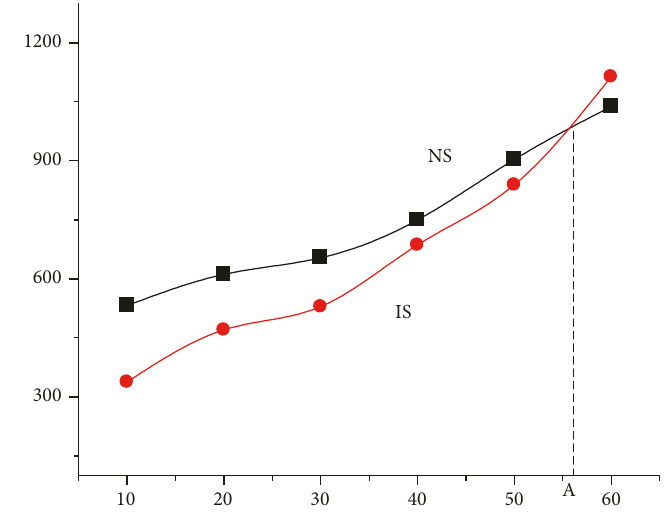
Figure 8: Demand uncertainty versus the retailer’s costs under two cases.